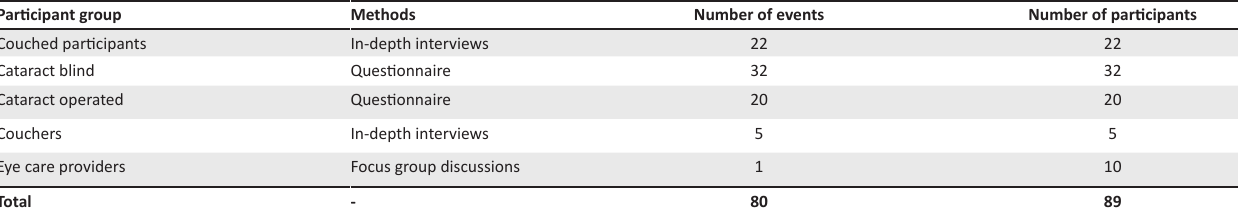
TABLE 1: Methods and number of events and participants in each group. Participant